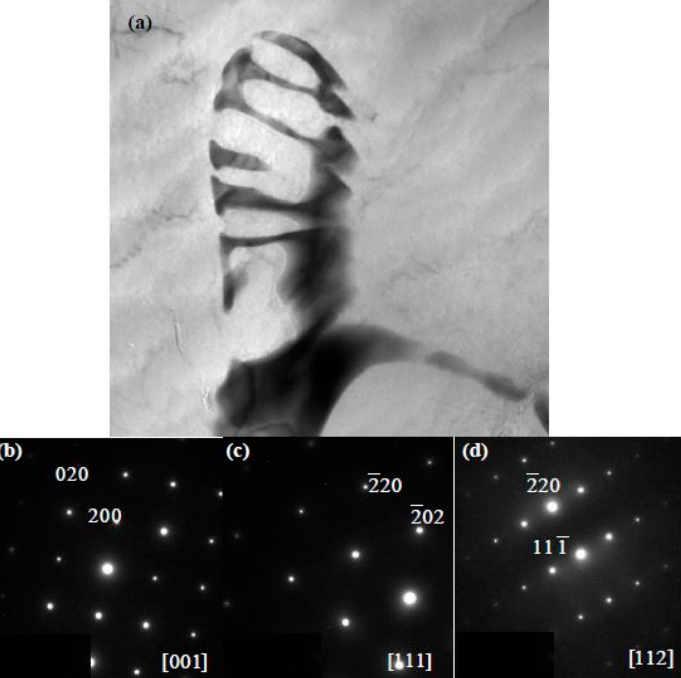
Figure 5. Identification of W-phase with the skeleton morphology by TEM in Mg-1Zn-0.333Gd alloy (Sample 39): ( a ) BF image, and ( b – d ) SAED patterns along [001], [111] and [112] zone axis, respectively. The W-phase has a composition of approximate Mg 31 Zn 45 Gd 24 (Zn/Gd = 1.9, at.%) and it is identified to have a face centered cubic (fcc) structure with a lattice parameter of a = 0.6927 nm.